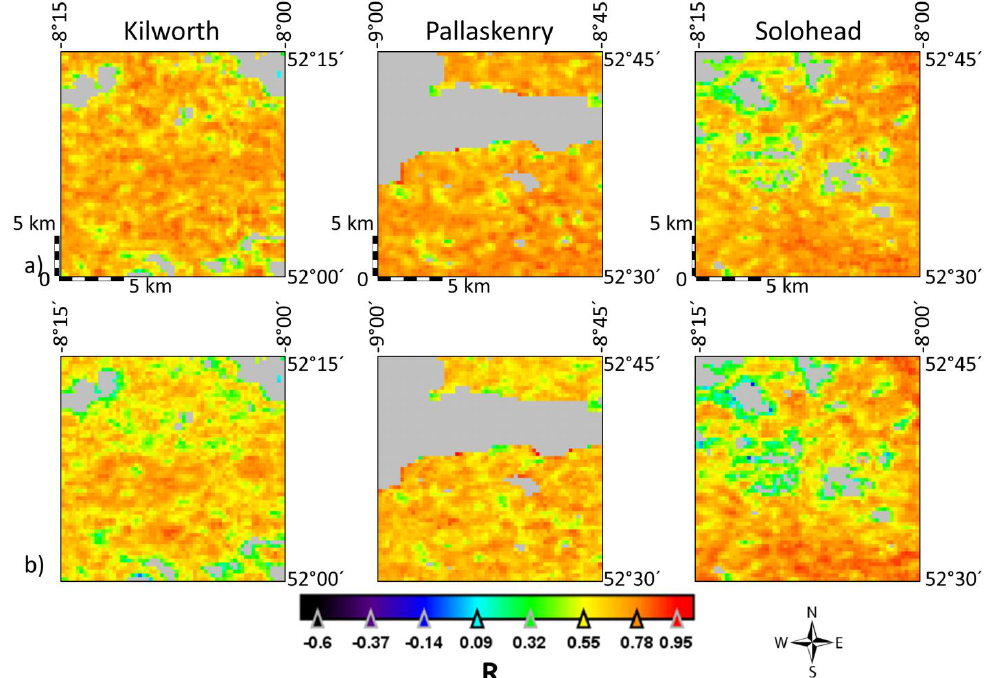
Figure 7. ( a ) ASAR SM vs. ECV and ( b ) ASAR SM vs. in situ SM correlation maps evaluated for each ASAR WS pixel (1 km × 1 km after